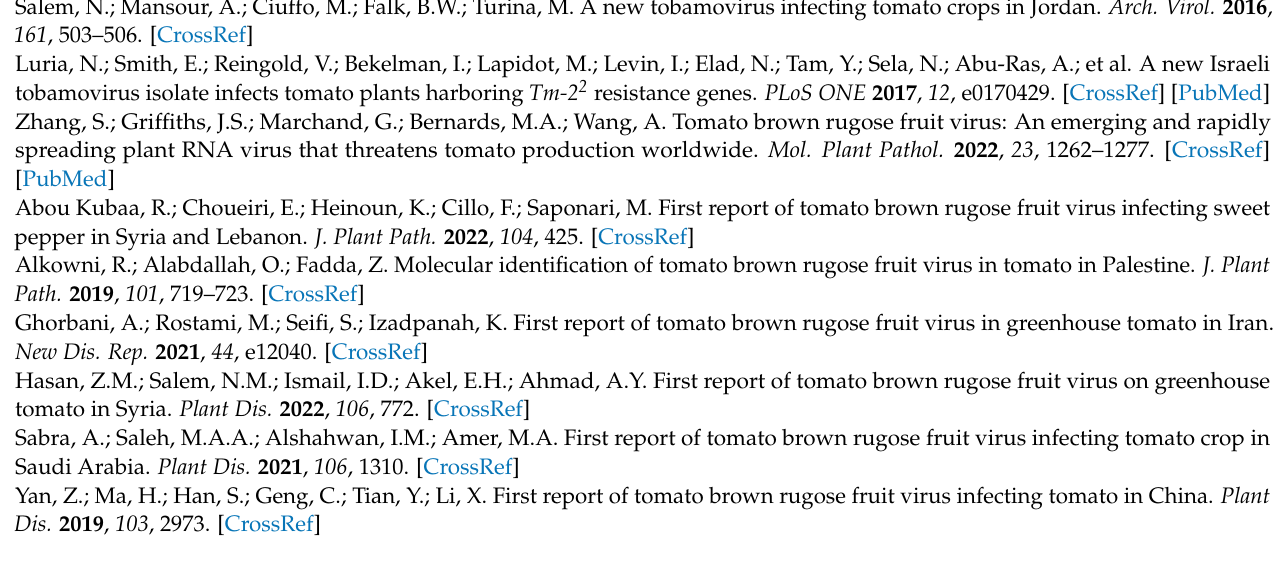
Supplementary Table S4. Virus infection status to assess the effectiveness of treatment against ToBRFV using serial dilutions of Virocid and Prevento, Experiment-1; Supplementary Table S5. Virus infection status to assess the effectiveness of treatment against ToBRFV using serial dilutions of Virocid and Prevento,